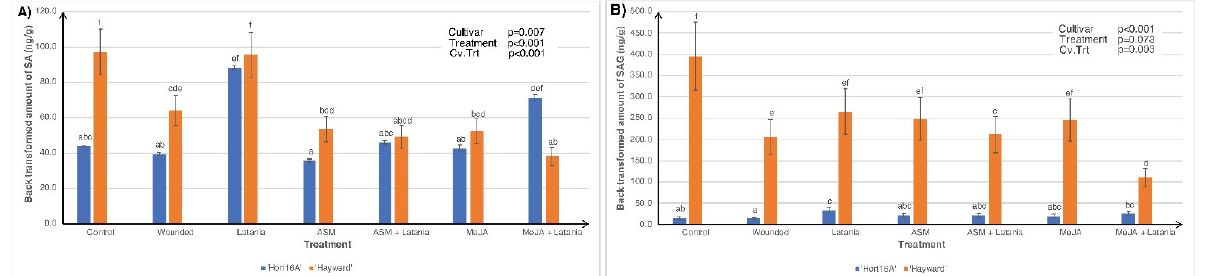
Figure 2. Phytohormone concentrations measured in ‘Hort16A’ and ‘Hayward’ kiwifruit leaf tissue, in 2018 of salicylic acid (SA) in ( A ); and salicylic acid glucoside (SAG)—an inert storage form of SA, in ( B ). Leaves were left unsprayed or were treated with 0.2 g/L Actigard™ (ASM) to induce the SA pathway or with 0.05% v / v methyl jasmonate (MeJA) to elicit the jasmonic acid (JA) pathway. Latania scale crawlers (approximately 200/leaf) were applied seven days later, or leaf wounding (to imitate scale feeding) was achieved with a fine needle. Control plants were left untreated. Although leaves were sampled for phytohormone measurements both two and seven days post scale infestation (psi), only the two-day psi results were significant and presented here. There were five replicate plants per treatment. The Y-axis concentration scale is different for each phytohormone. P-values from ANOVA are shown in the top right-hand corner of each bar chart, and each chart plots the cultivar × treatment interaction (Cv.Trt). Error bars give the standard errors, and different lettering (a, b, c, d, e, f) indicates statistically significant treatment differences, as shown by LSD, p ≤ 0.05. Contrary to the 2016 results, none of the treatments in 2018, including MeJA, had any significant effect on JA levels in either cultivar; hence the data are not shown. However, levels of the precursor of JA (cis-12-oxyphytodienoic acid (cis-OPDA)) were significantly higher in leaves from the MeJA treatments than those from all other treatments, especially in ‘Hort16A’ at two days psi (Figure 3A). The same trend was seen with the most bioactive form of JA (jasmonic acid isoleucine (JA-Ile)) in the MeJA + Latania treatment in ‘Hort16A’ at two days psi only (Figure 3B). In contrast, the less active (dihydrojasmonic acid (DH-JA)) and inert (12-hydroxy jasmonic acid (12-OH-JA)) forms of JA were present in significantly higher concentrations in ‘Hayward’ than in ‘Hort16A’, especially in the ASM treatments for DH-JA at both two and seven days psi (Figure 3C,D) and in the MeJA treatments for 12-OH-JA at both two and seven days psi (Figure 3E,F). Concentrations of 12-OH-JA were greater at two days than at seven days post scale application (Figure 3E,F). In common with the 2016 results, Cv.Trt interactions were not significant at either psi time for the 2018 ABA data; thus, they are not